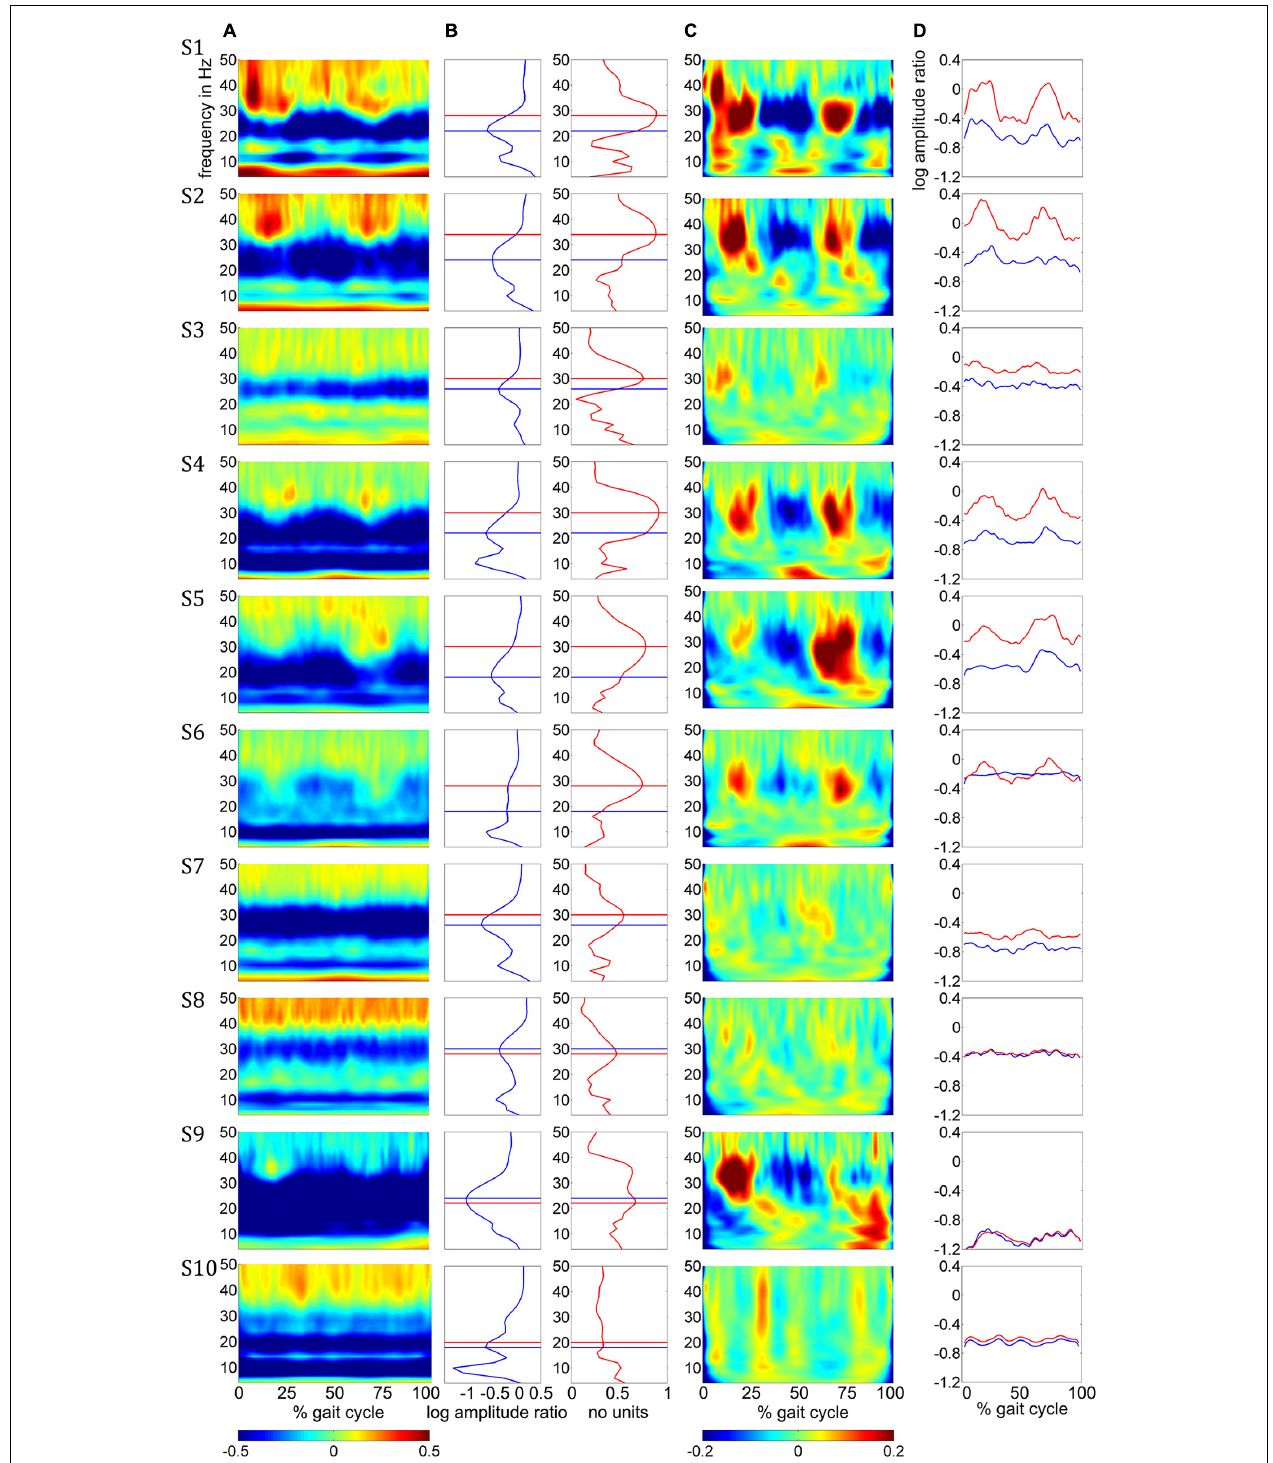
FIGURE 3 | (A) Time-frequency ERD/ERS plots from the 10 subjects illustrating spectral changes between active walking and upright standing. Activity in log spectral ratios, spectral de/increase in blue/red (B) ERD (blue) and GPM (red) as a function of frequency. (C) TF plots illustrating amplitude modulations relative to the gait cycle mean